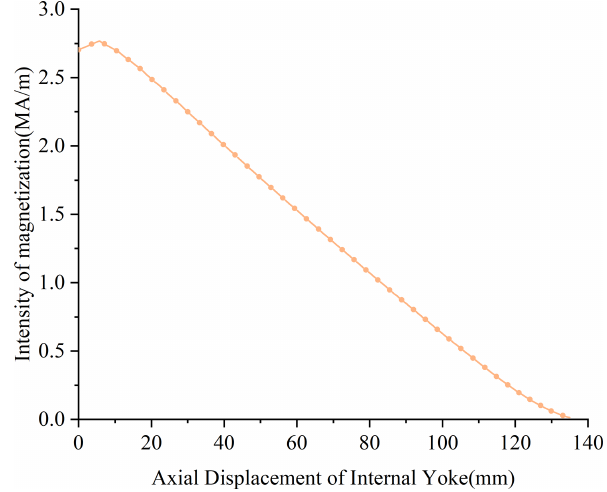
Figure 10. Magnetization intensity curve of yoke in the macro- motion stator.